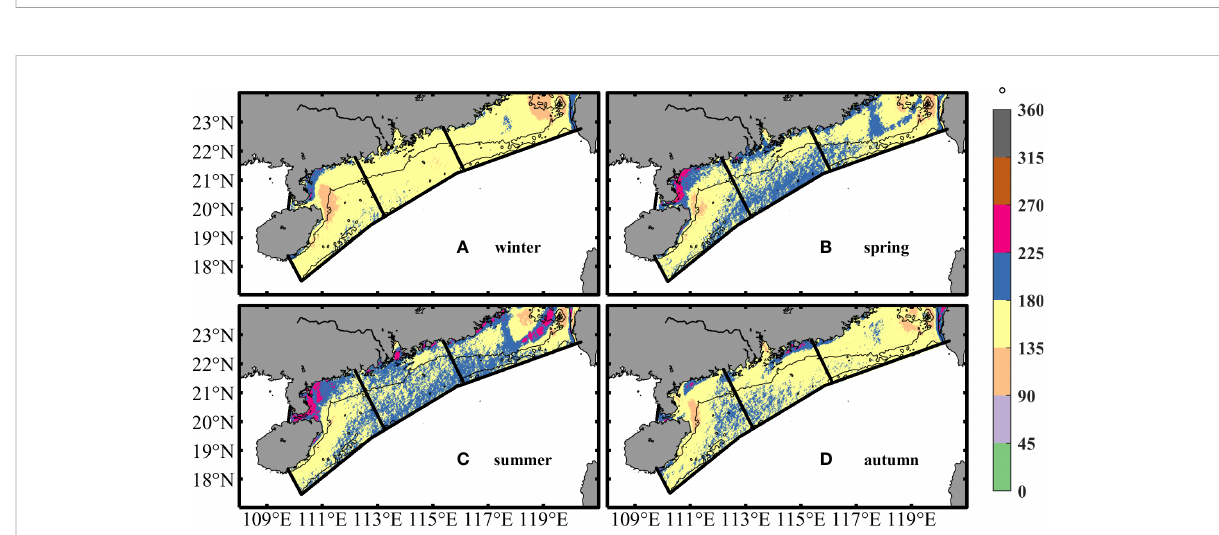
FIGURE 7 Mean SST gradient direction at frontal pixels averaged over 2002 − 2021 for (A) winter(January − March), (B) spring(April − June), (C) summer (July − September), and (D) autumn(October − December).The black lines are the 50-m and 200-m isobaths.